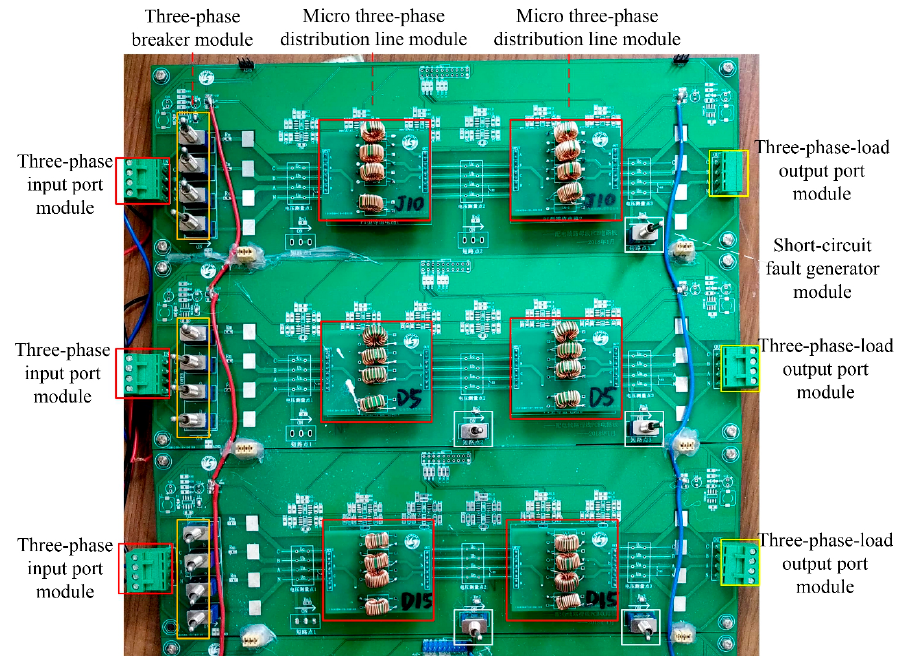
Figure 2. Prototype of the scaled-down educational distribution network platform. Table 1. Equipment list and its cost in our proposed platform.